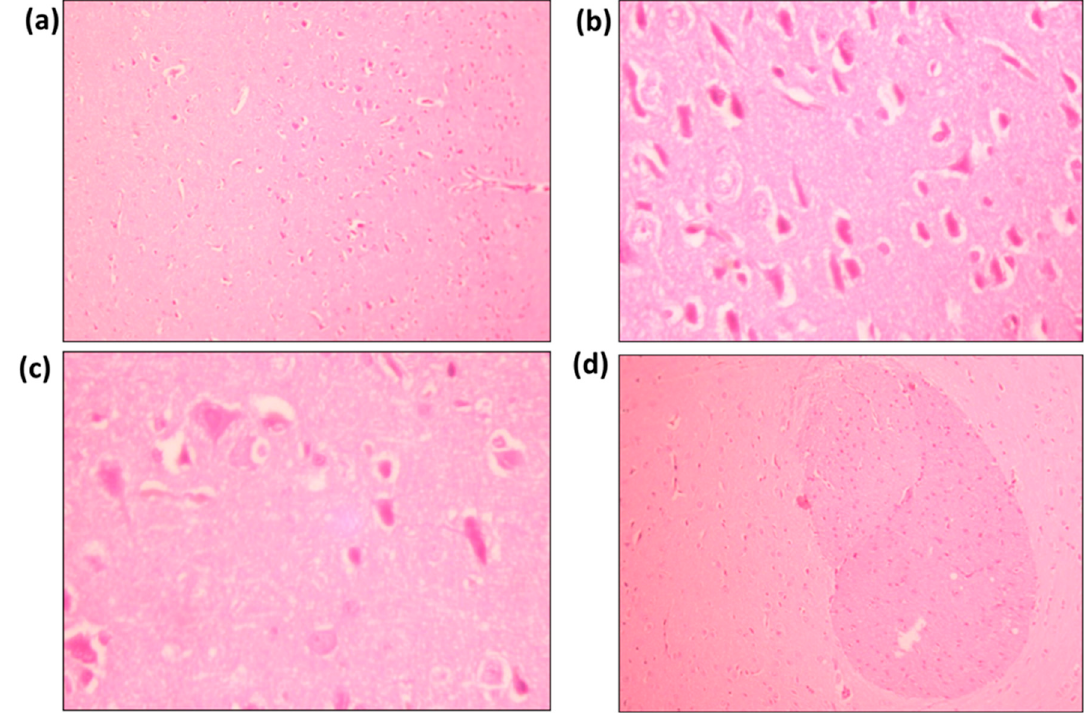
Figure 7. Histological features of ( a ) Standard; ( b ) Rutin I; ( c ) Rutin II; ( d ) Negative